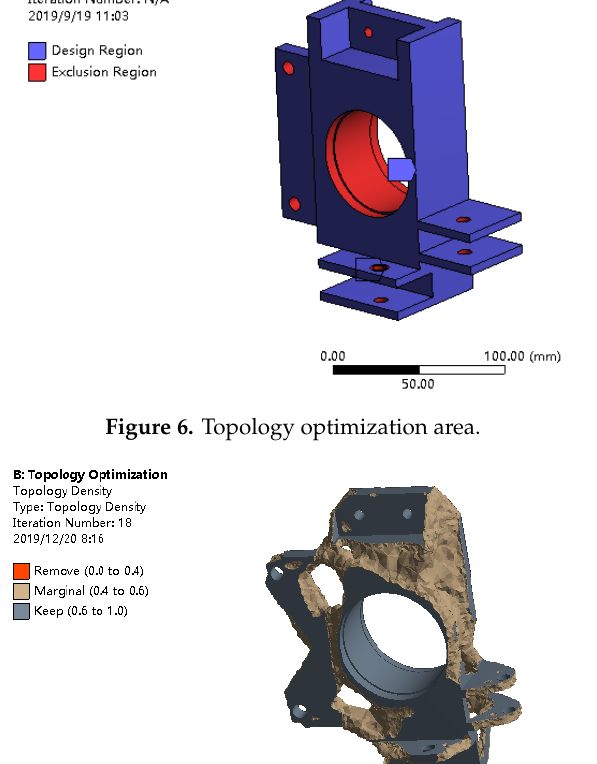
Figure 7. Topology optimization result.